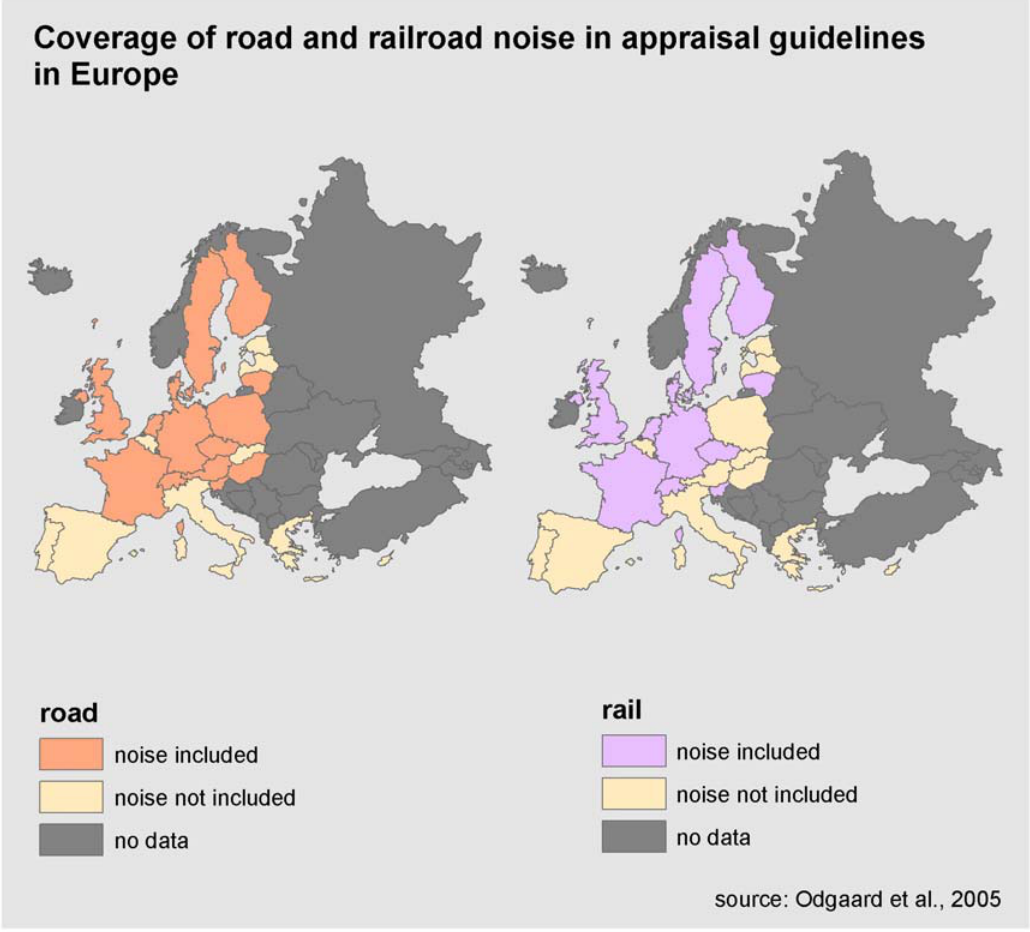
Figure 1. Coverage of road and railroad noise in appraisal guidelines in Europe Source: Odgaard et al., 2005; DEFRA,